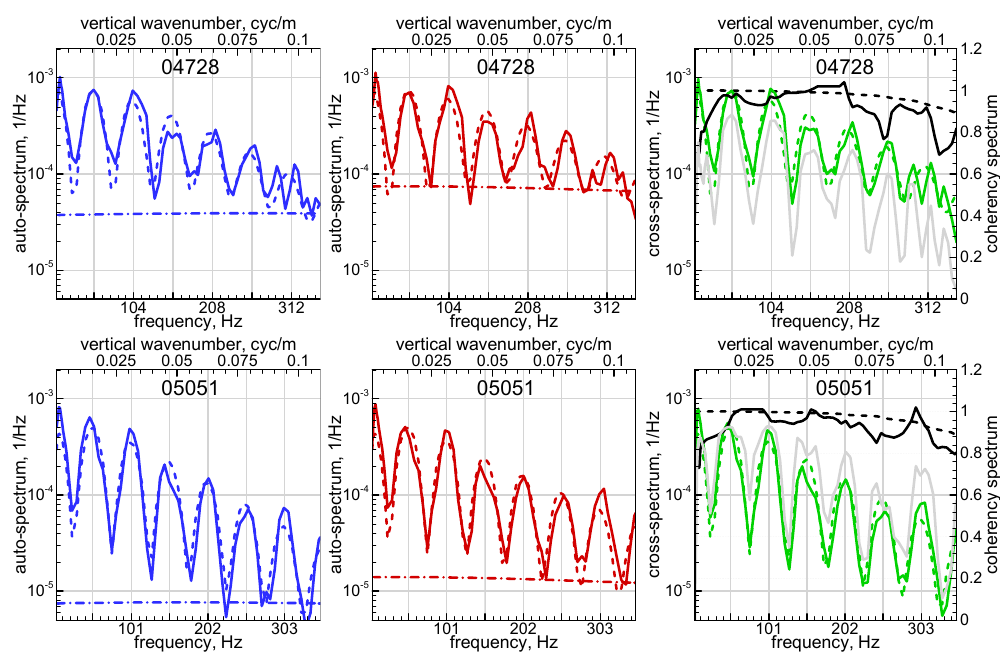
Fig. 3. Illustration of detecting isotropic and anisotropic components of scintillation spectra. Left panels (for the blue photometer) and centre panels (for the red photometer): detected experimental (solid lines) and theoretical (dashed lines) auto-spectra of anisotropic scintillations and theoretical auto-spectra of isotropic scintillations (dot-dashed lines). Right panels: experimental (solid lines) and theoretical (dashed lines) moduli of cross-spectra (green) and coherency spectra (black) of the detected anisotropic component; grey lines indicate the measured coherency spectrum.